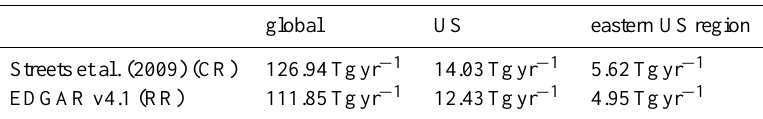
Table 1. Summary of 2005 SO 2 anthropogenic emissions for the entire globe, the US (125–65 ◦ W; 25–50 ◦ N) and over the eastern US (90–70 ◦ W; 35–45 ◦ N) where a lot of power plants are located.